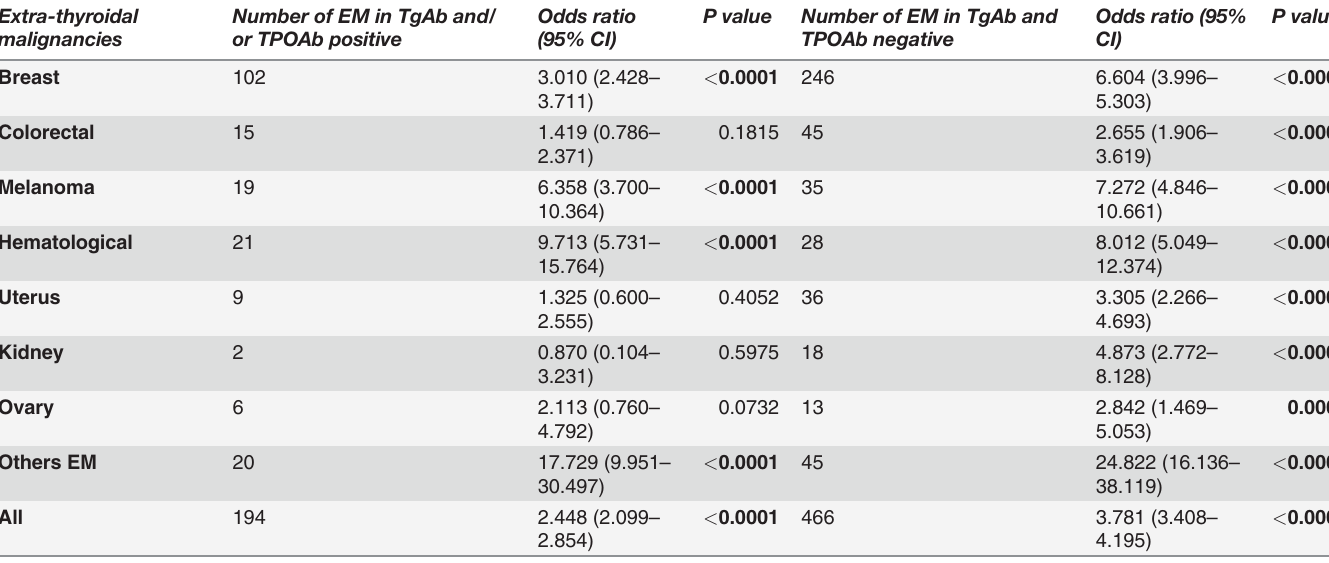
Table 3. Prevalence of Extra-Thyroidal Malignancies in Patients Positive (n = 2,369) or Negative (n = 3,820) for TgAb and/or TPOAb. Extra-thyroidal